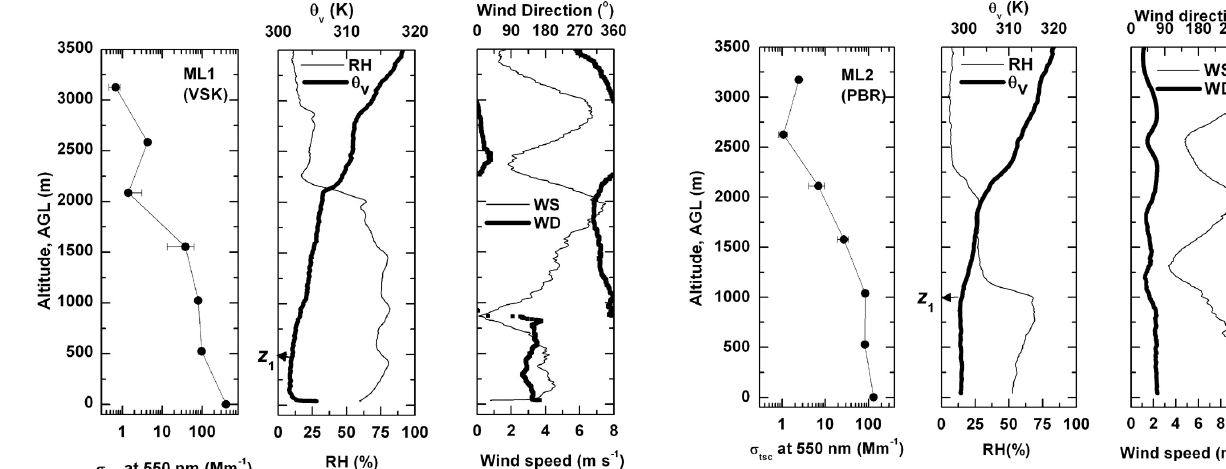
Fig. 4. Vertical profiles of σ tsc (left panel); virtual potential tem- perature ( θ v , thick solid line in the middle panel), relative humidity (RH, thin solid line in the middle panel); wind direction (WD, thick solid line in the right panel), wind speed (WS, thin solid line in the right panel) over VSK during ML1. z 1 denotes the vertical extent of the well-mixed region.